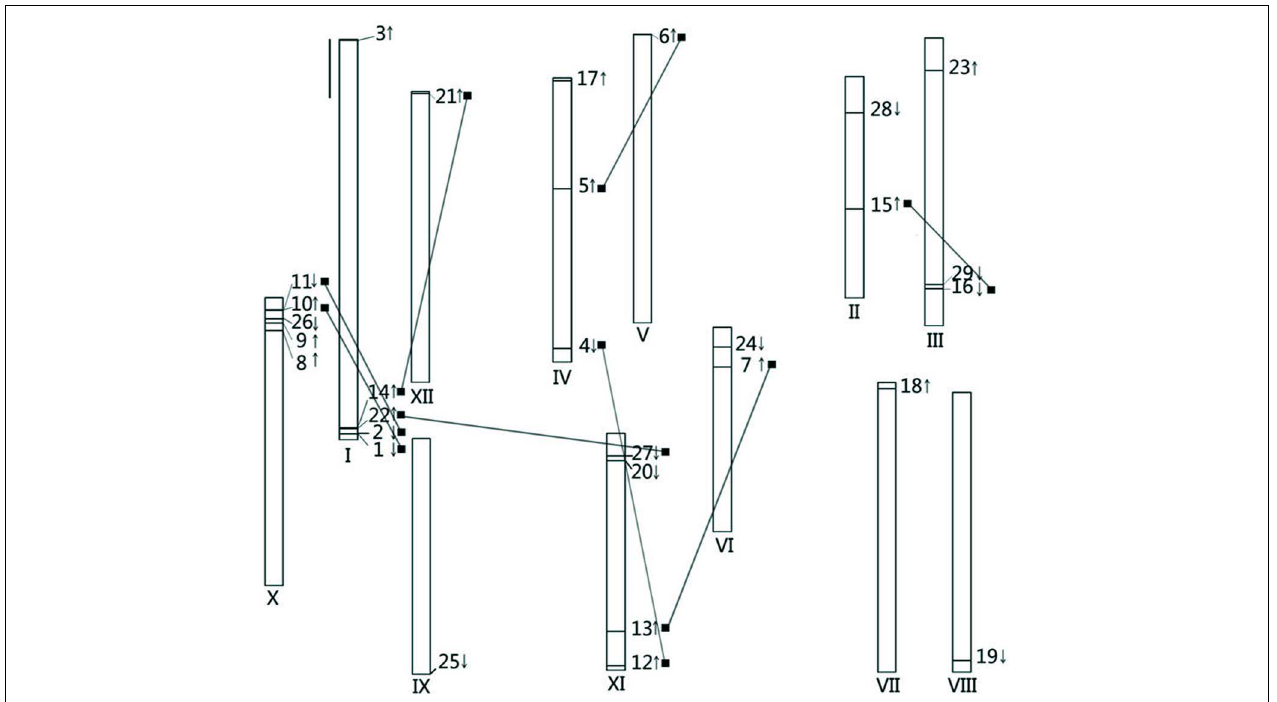
FIGURE 1 | Chromosomal distributions of calcium-dependent protein kinases (CDPK) genes in the tomato genome. The roman numerals under each chromosome represent the nomber of the chromosomes. The arrows accompanied with each CDPK gene stand for the gene encoding direction. Each of paralogous gene pair is linked by the black line. The black bar on the left up concern means the length of 10